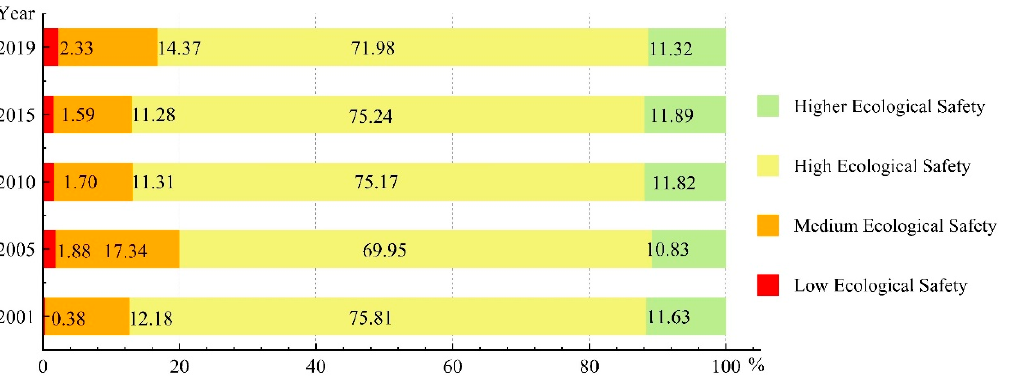
Figure 3. Spatial distribution of ES levels in the HRB in 2001, 2005, 2010, 2015, and 2019.